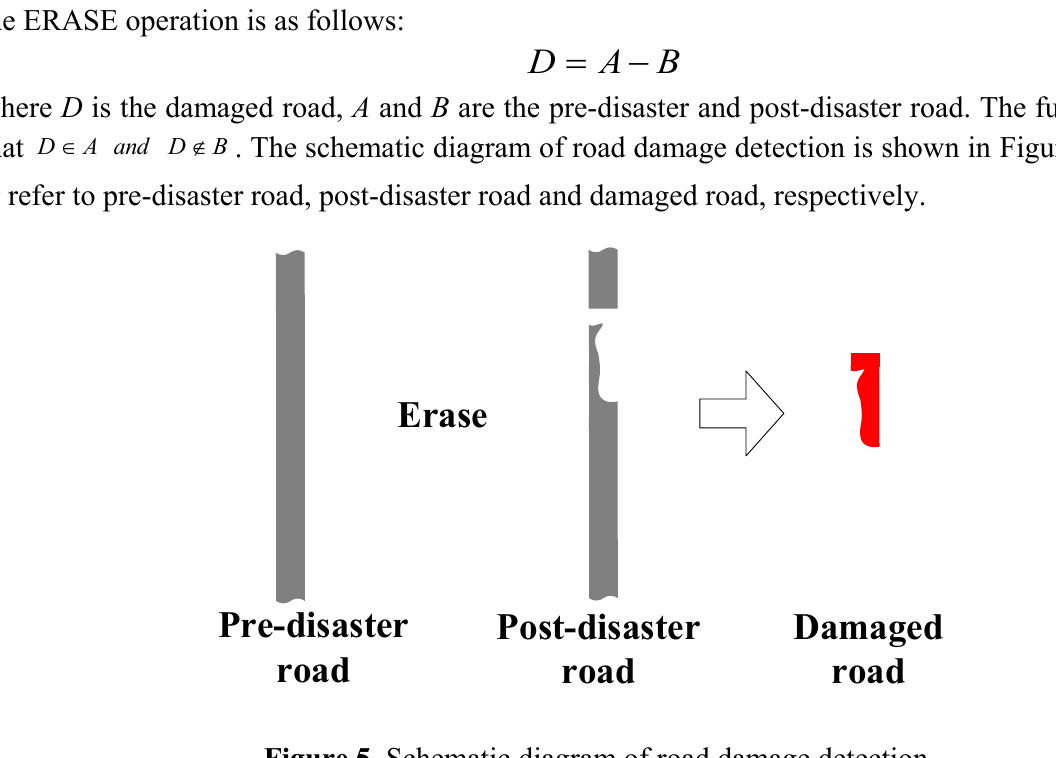
Figure 5. Schematic diagram of road damage